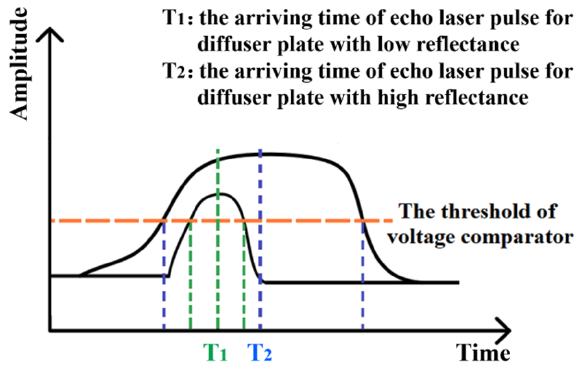
Figure 4. The gray-value distance correction experimental platform.